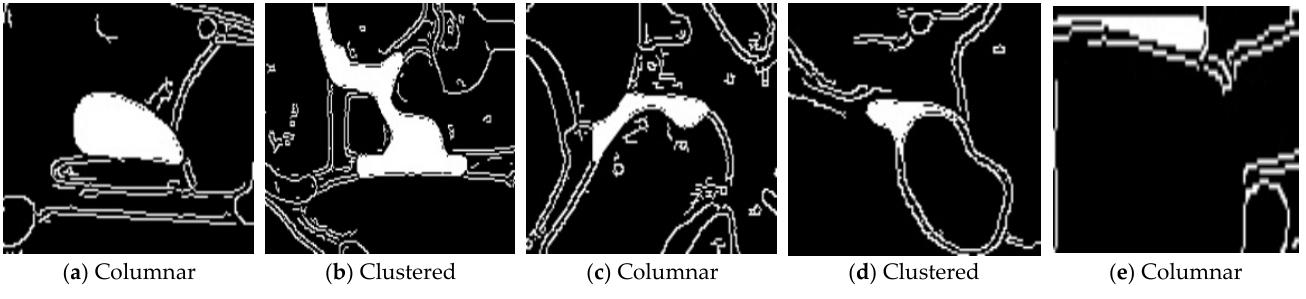
Figure 11. Test results examples.